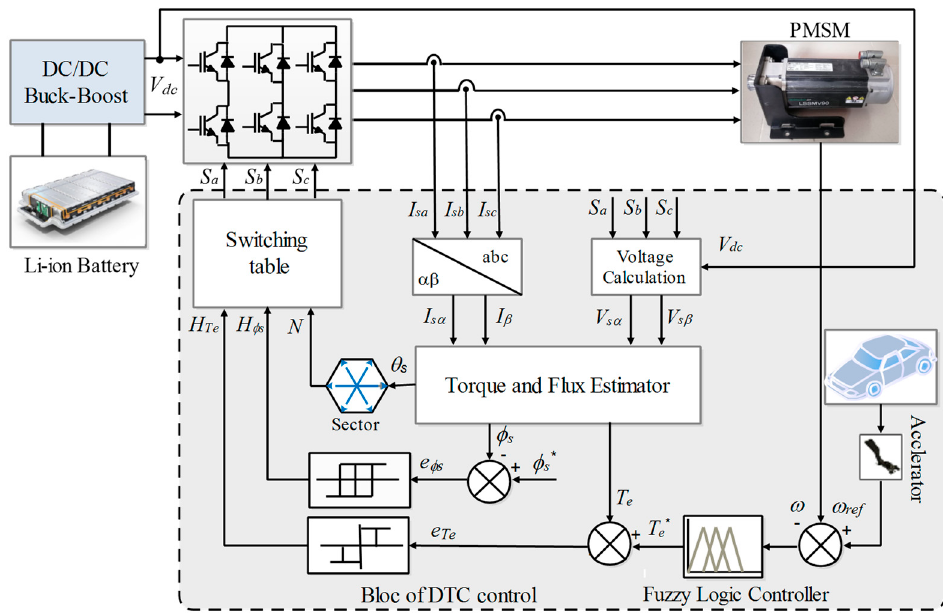
Figure 5. Bloc diagram of the DTC technique for a PMSM in EV system. Table 4. Switching table of DTC technique.